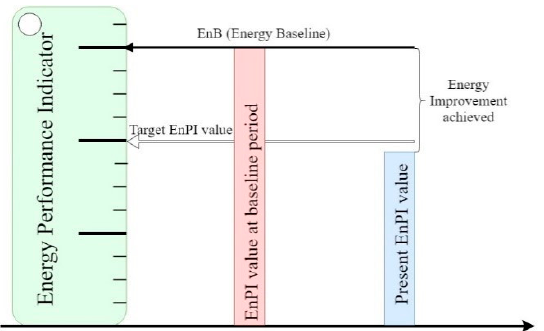
Figure 1. Concept of energy performance indicators (EnPI) in baseline period and implemented period.